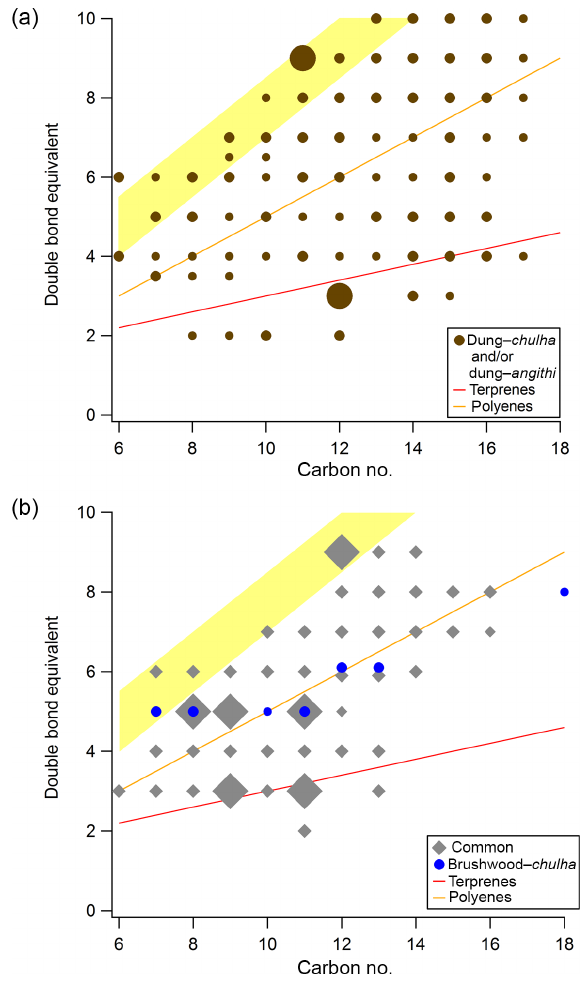
Figure 5. Double bond equivalent (DBE) as a function of the car- bon number for (a) a combined set of compounds detected from all dung cook fires (brown circles) and (b) compounds that all cook fires have in common (grey diamonds as well as compounds ex- clusively found in brushwood (blue circles). Markers representing one or multiple species are sized by their LOW, MEDIUM, and HIGH designations. The curves illustrate theoretically where ter- penes (red) and polyenes (green) would fall. Similarly, the yellow- shaded region shows where PAHs would appear, including: cata- condensed PAHs with 0, 1, and 2 heterocyclic nitrogen atoms and circular